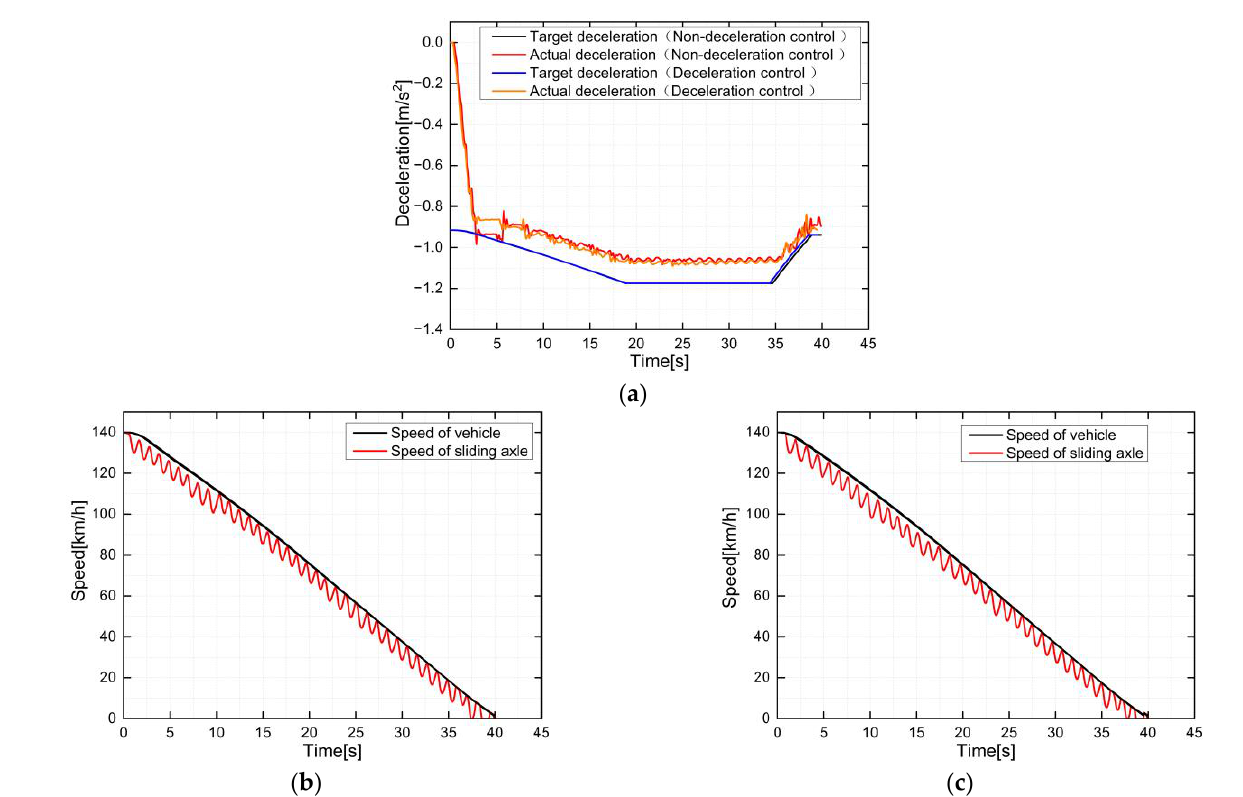
Figure 15. Anti-skid matching test results: ( a ) braking deceleration; ( b ) sliding axle speed under the non-deceleration control mode; ( c ) sliding axle speed under the deceleration control mode.